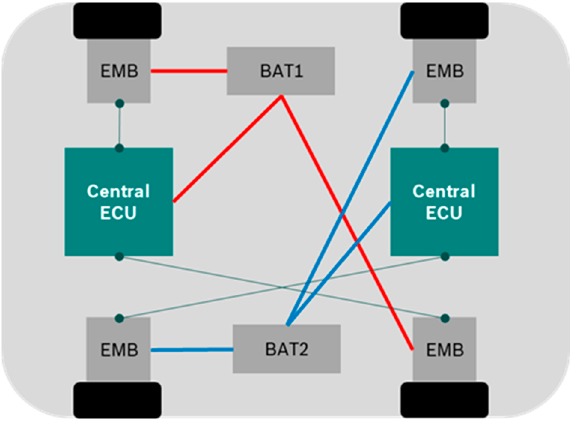
Figure 2. Scheme of an EMB system; shown is an exemplary X circuit